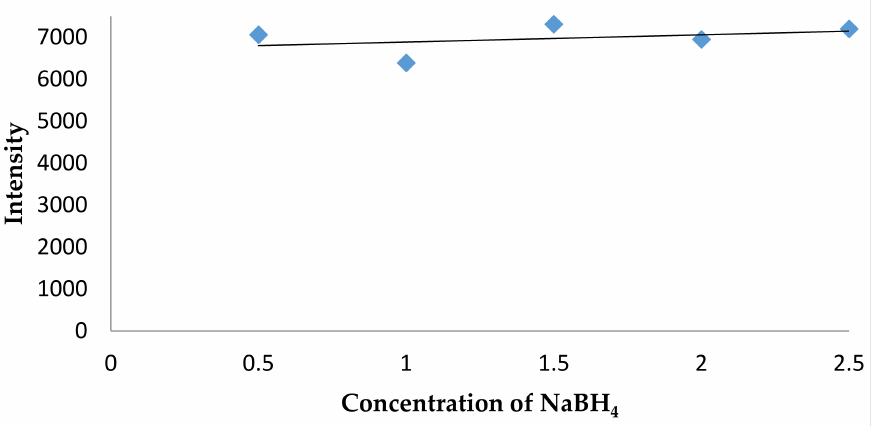
Figure 2. Optimization of NaBH 4